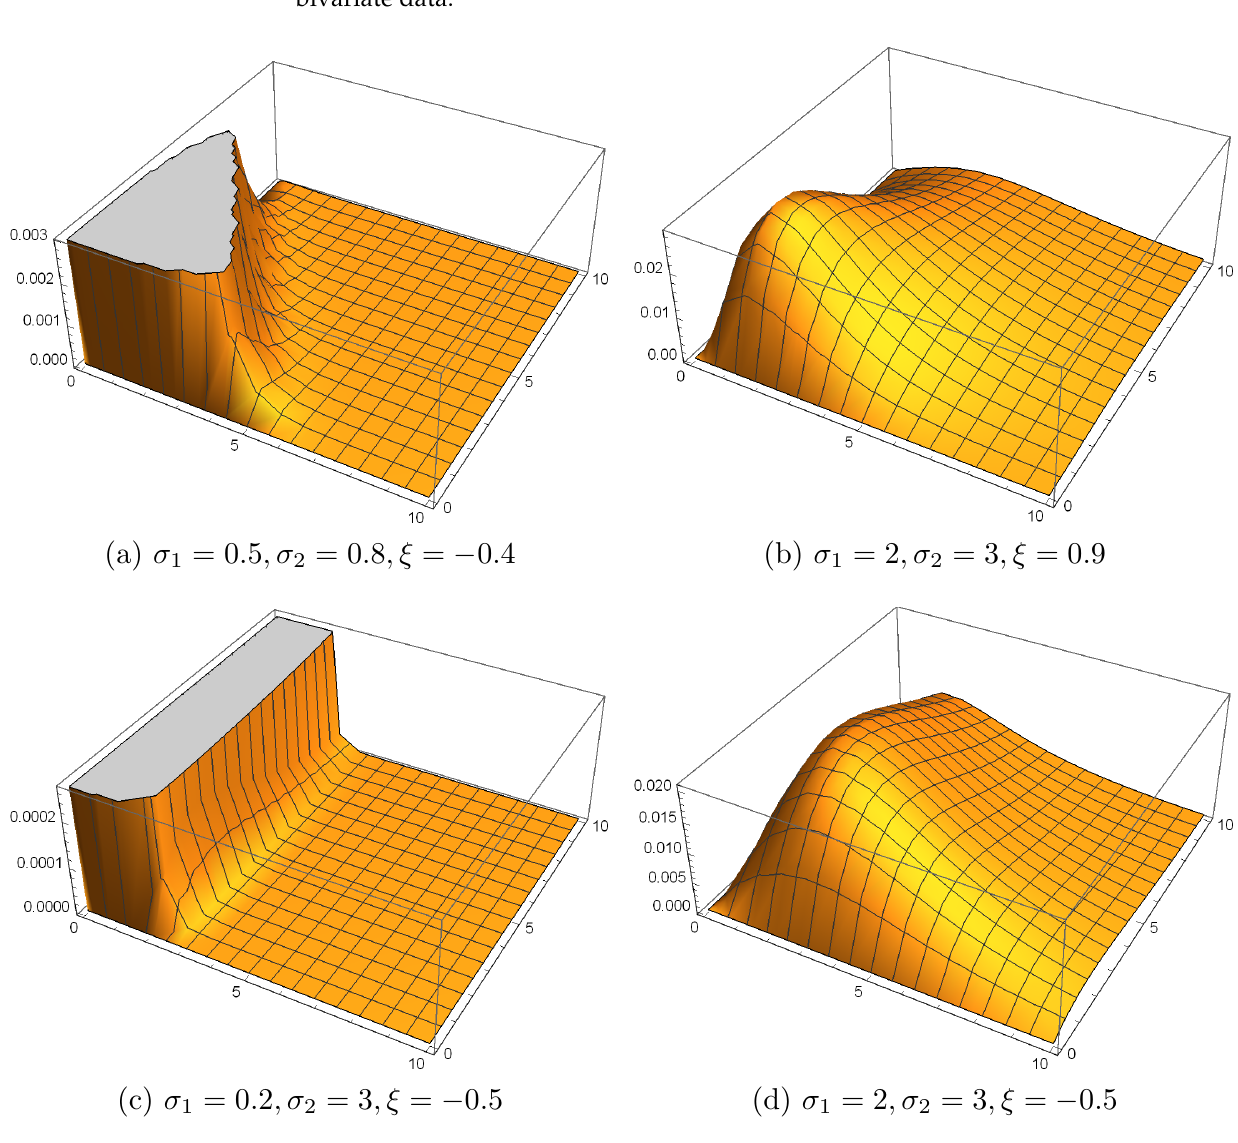
Figure 1: Pdf plots for varying values of parameters. Figure 1. Pdf plots for varying values of